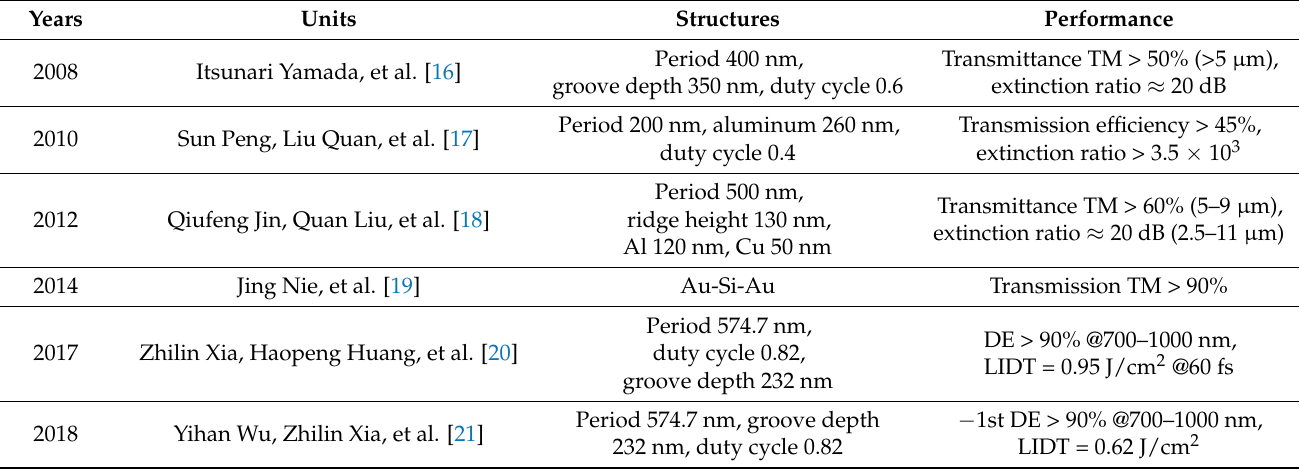
Table 1. Overview of metal film reflection gratings in recent